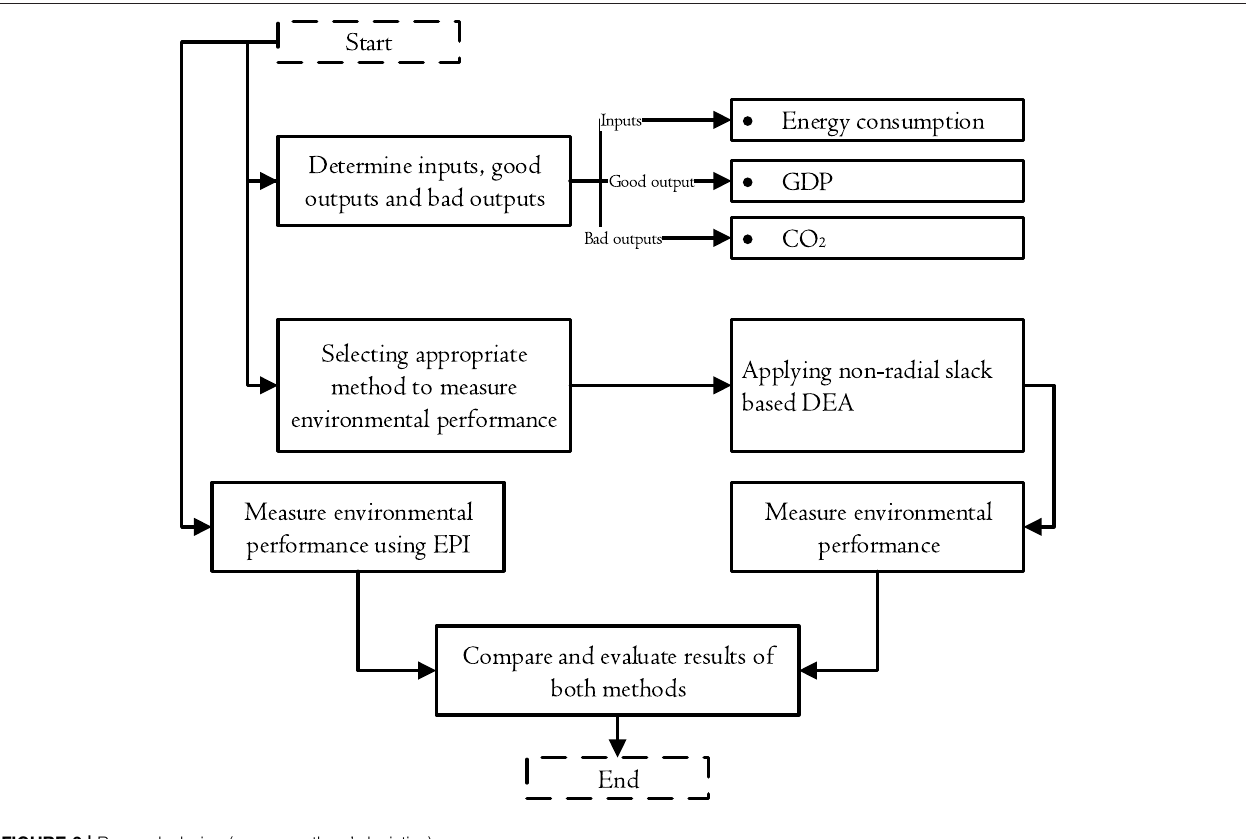
FIGURE 3 | Research design (source: authors ’